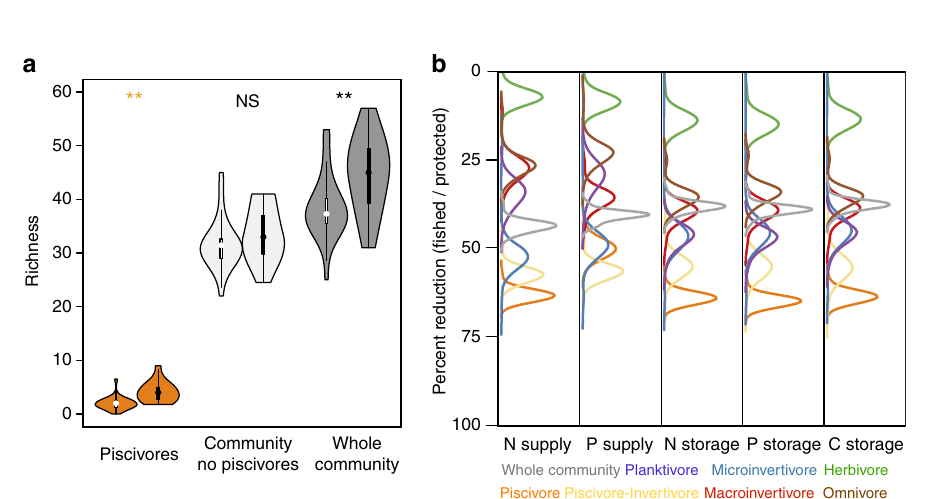
Figure 3 | Effects of fishing on species richness and contribution of trophic groups for nutrient supply and storage. ( a ) The number of species lost due to fishing in various components of the community: piscivores only, the community minus piscivores and the whole community. Violin bars with a white centre bar indicate reefs on which fishing occurs versus a black centre bar indicating protected reefs ( n ¼ 39 total communities). ‘**’ and ‘NS’ indicate statistical significance, and lack of significance, respectively, as determined by 95% confidence intervals overlap with zero from mixed-effects models. ( b ) Distributions of effect sizes illustrating the relative degree to which fishing reduces the supply and storage of nutrients by different trophic groups. Distributions represent bootstrapped (1000 iterations) per cent reductions in nutrient processes for each trophic group ( n ¼ 7) between fished and protected reefs ( n ¼ 39) (Supplemental Information: Human impacts